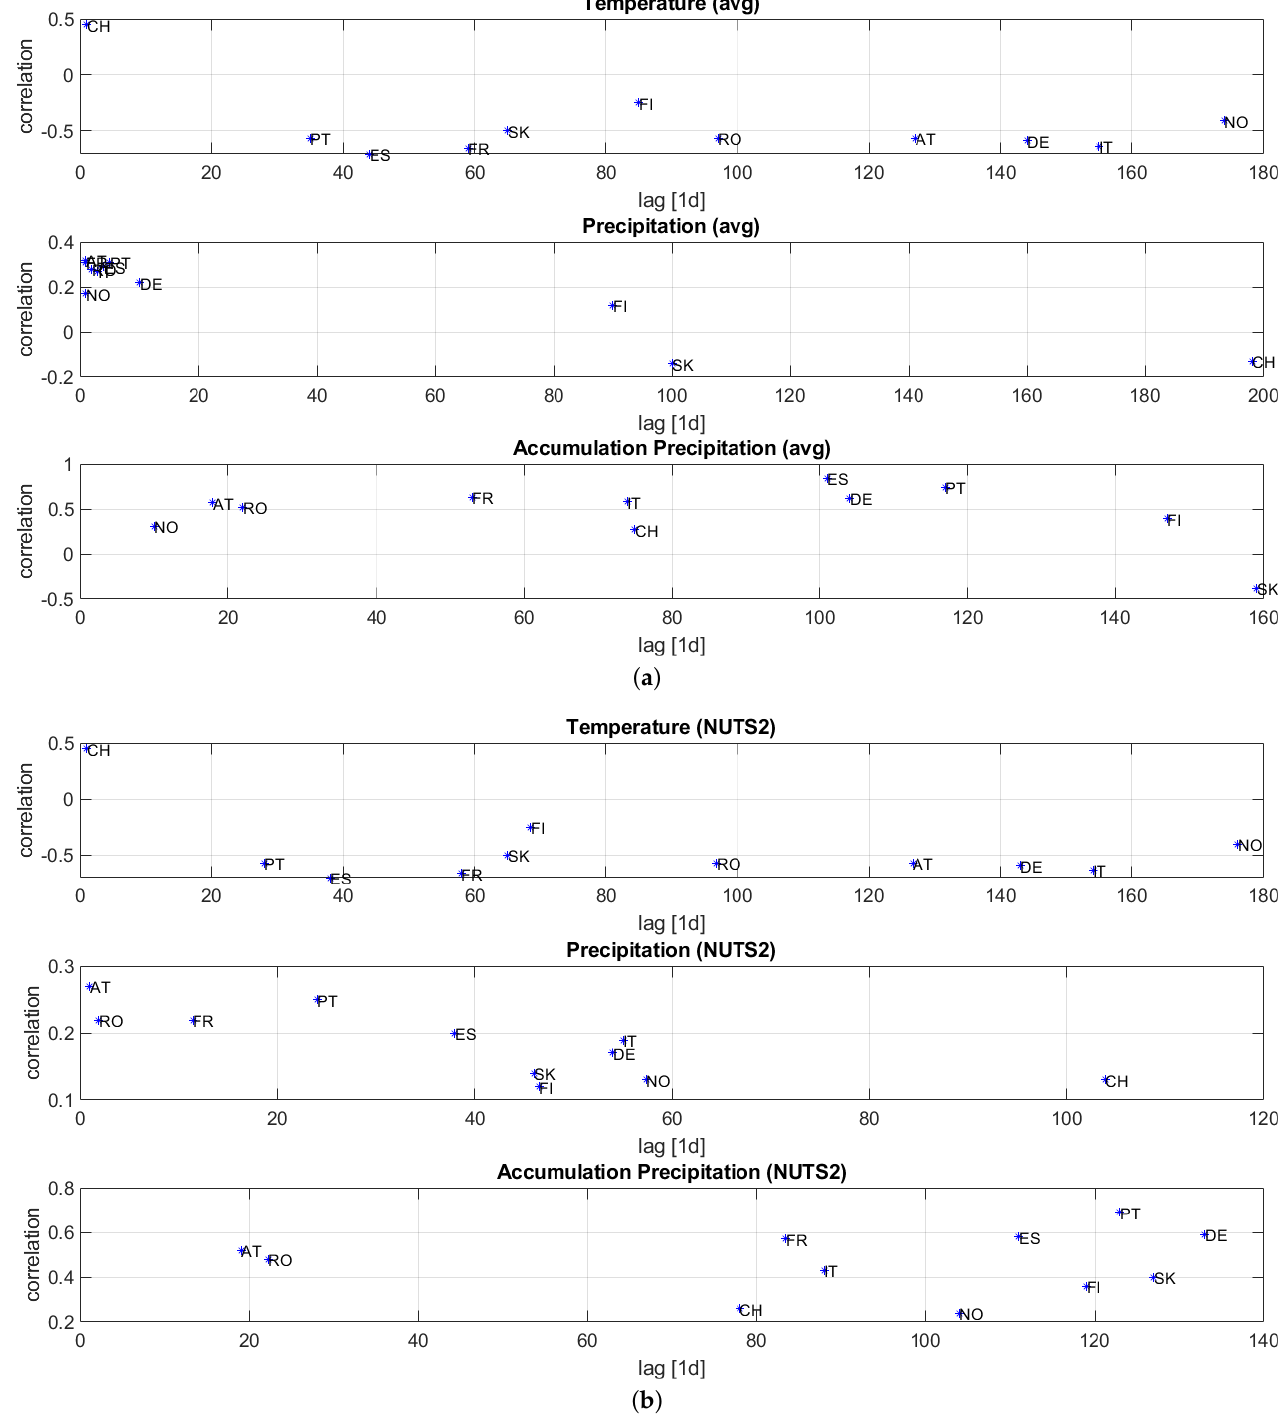
Figure 2. Optimal lag and corresponding maximum value of correlation for each country. ( a ) Predictors’ agrregation at country level. ( b ) Predictors’ agrregation at NUTS2